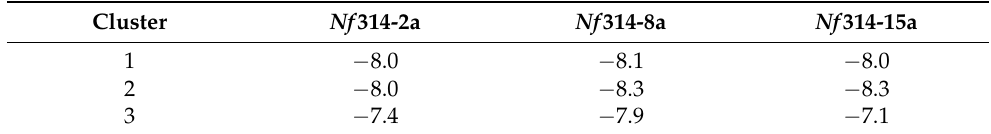
Table 1. Calculated binding energies (kcal/mol) from the three best clusters of each Nf 314-ligand complex.